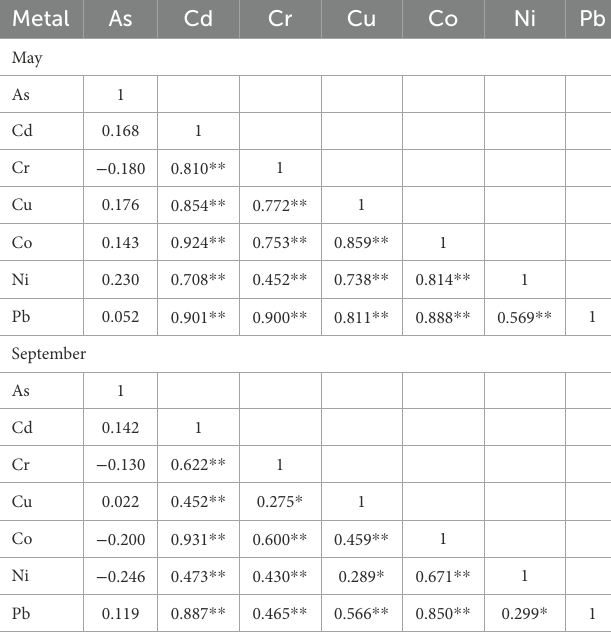
TABLE 3 Analysis of the correlation coefficients of heavy metals in topsoil in May and September. Metal